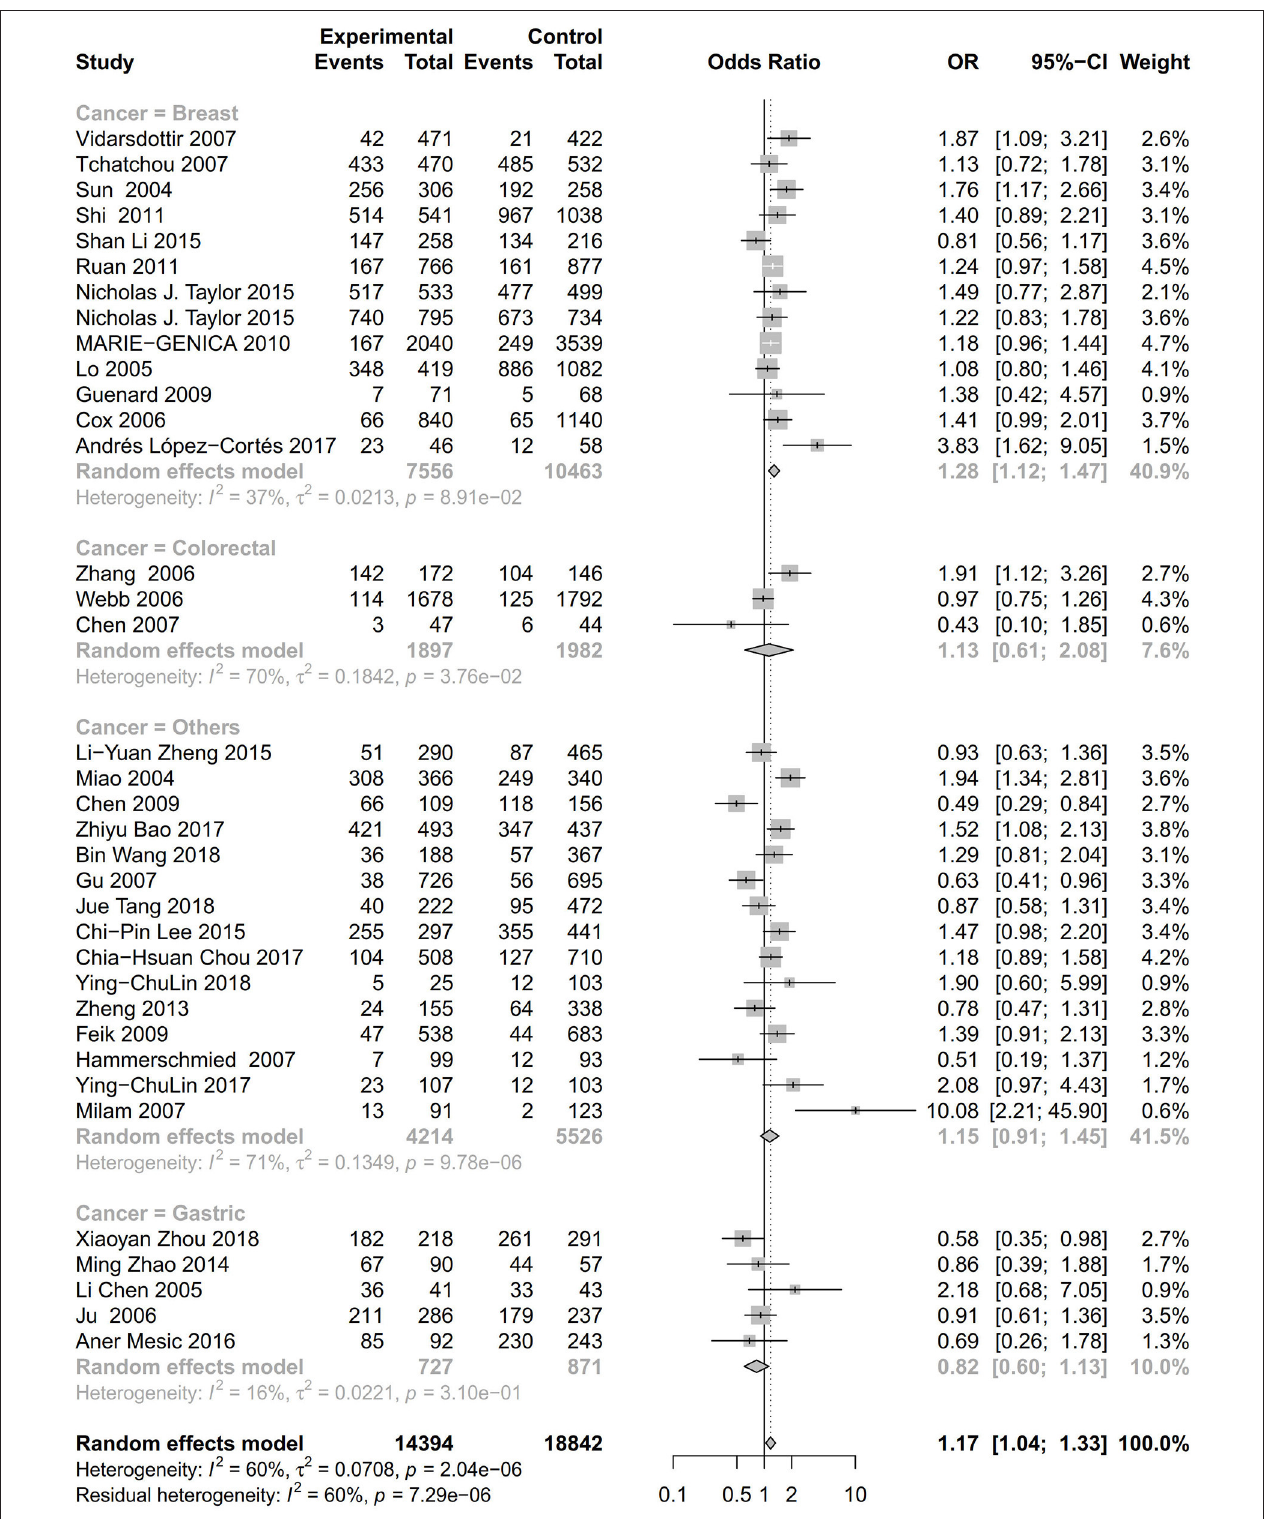
FIGURE 5 | Stratification analysis of the association between the AURKA rs2273535 T > A polymorphism and cancer risk by cancer type under the homozygous model (AA vs. TT).